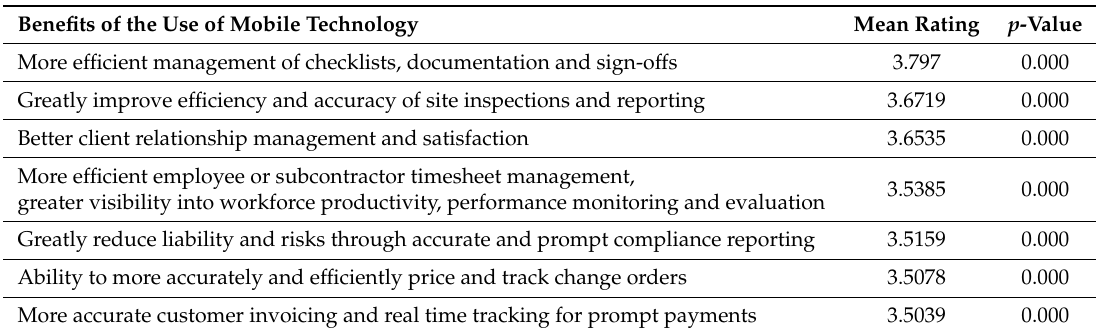
Table 4. Perceived Benefits of The Use Of Mobile Technology in Construction.